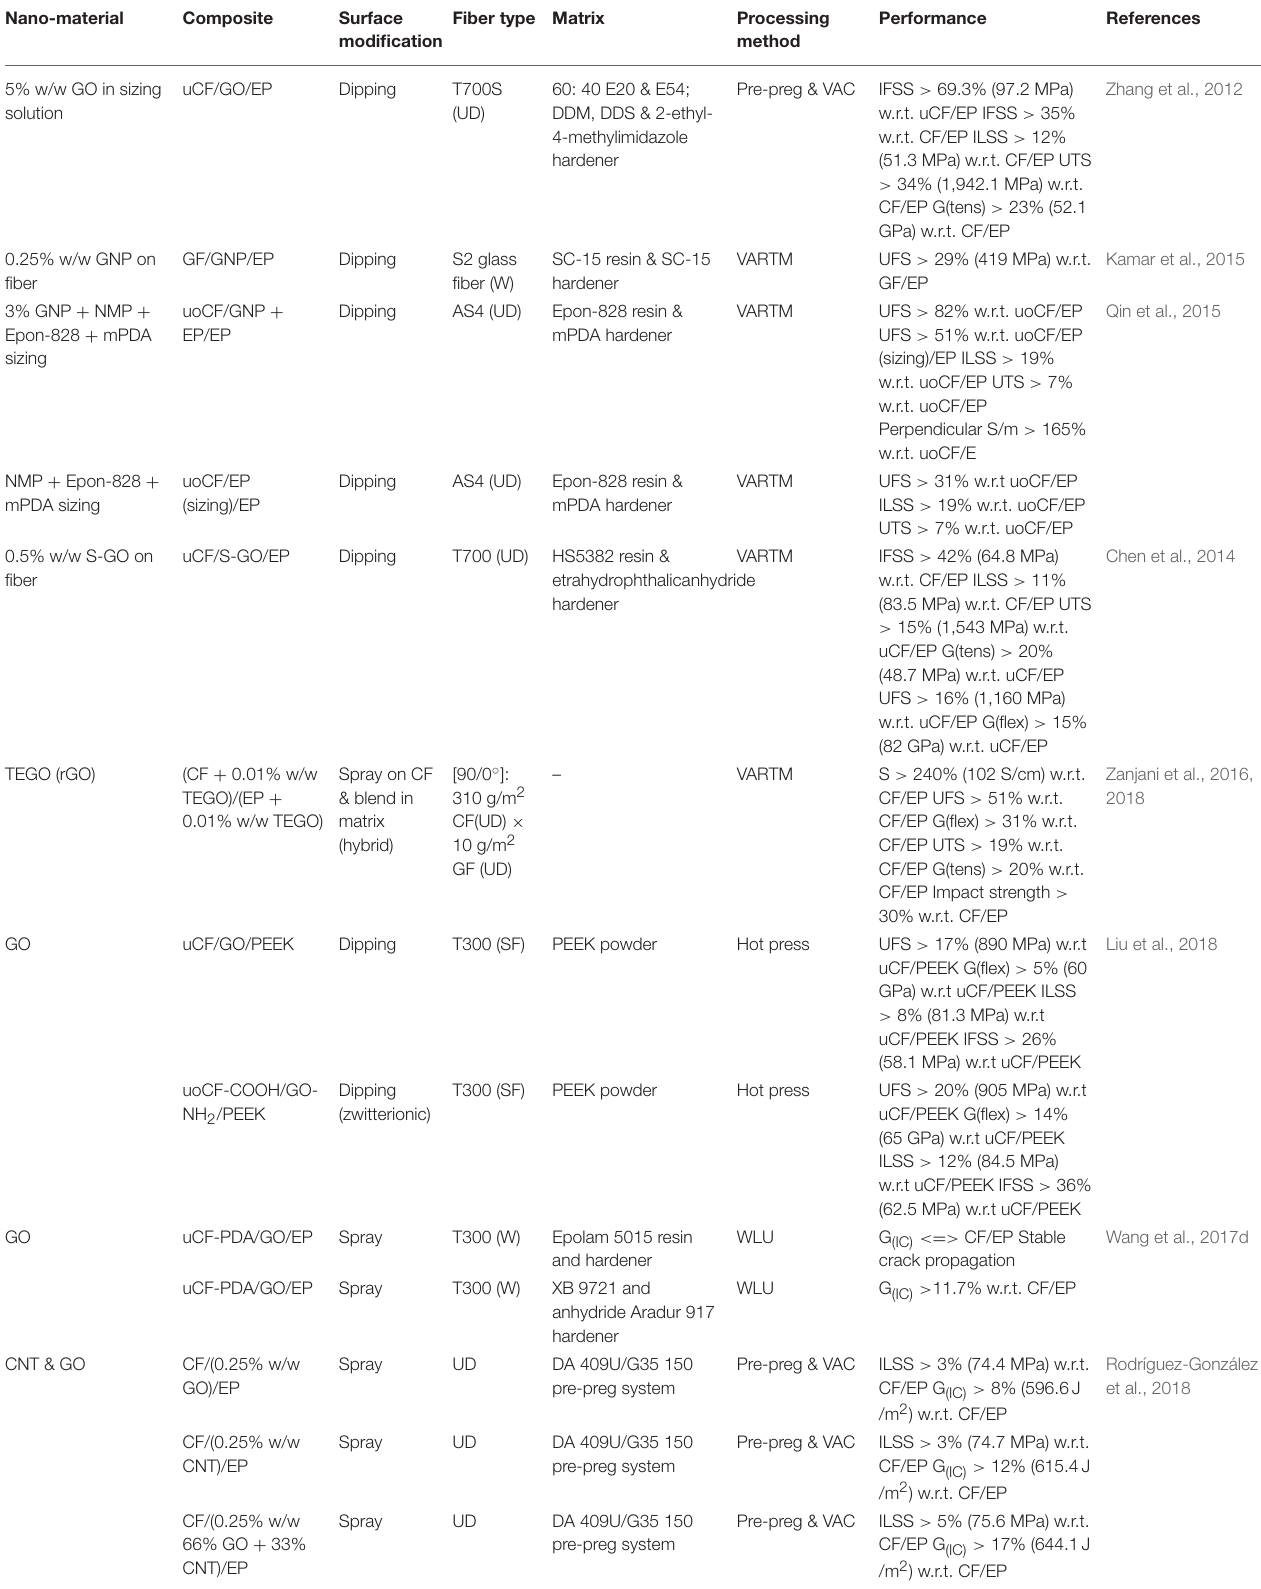
TABLE 3 | A summary of results from literature investigating dipping and spraying methods to modify the fiber surface properties.